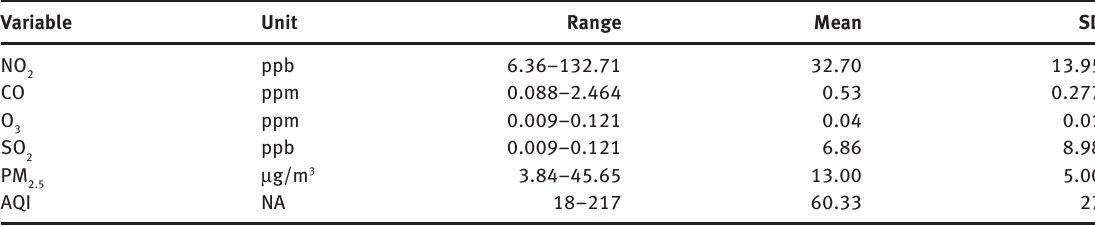
Table 2: Statistical Measures of Houston Data